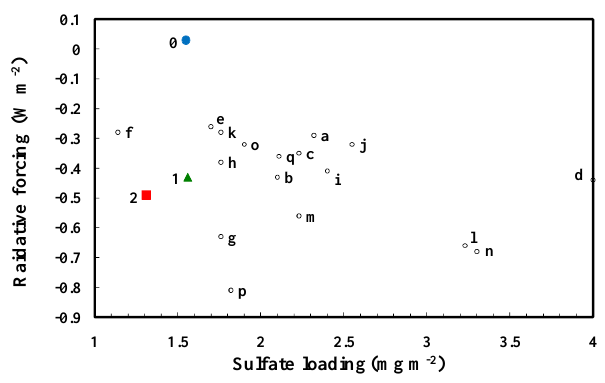
Fig. 5. Comparison of sulfate burden and direct effect between GCCM and other model results. The filled circle, triangle and square represent the GCCM results of A0–N0 (blue circle labeled “0”), A1–N1 (green triangle labeled “1”) and A2–N2 (red square labeled “2”), respectively. The letters next to the open circles indi- cate results from the following studies: (a) Boucher and Ander- son (1995), (b) Chuang et al. (1997), (c) Feichter et al. (1997), (d) Ghan et al. (2001a), (e) Graf et al. (1997), (f) Hansen et al. (1998), (g) Haywood and Ramaswamy (1998), (h) Haywood et al. (1997a), (i) Iversen et al. (2000), (j) Jacobson (2001), (k) Kiehl and Briegleb (1993), (l) Kiehl and Rodhe (1995), (m) Kiehl et al. (2000), (n) Koch et al. (1999), (o) Myhre et al. (1998c), (p) Penner et al. (1998b), (q) van Dorland et al.